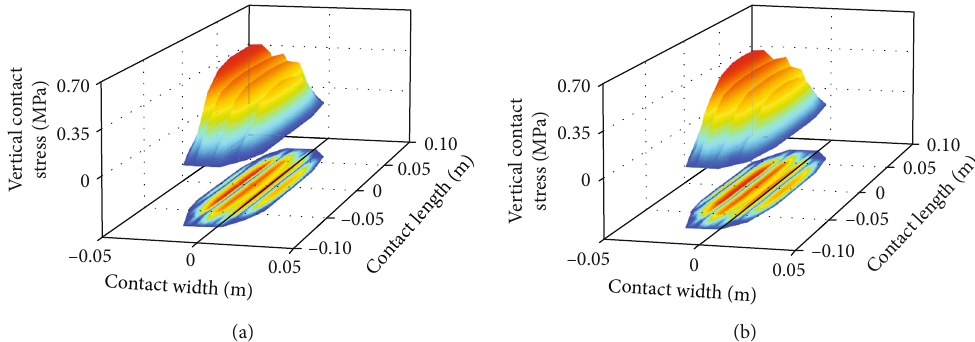
Figure 10: Contact patch and pressure distribution during steering with a 10 ° roll angle: (a) control tire; (b) bionic tire.